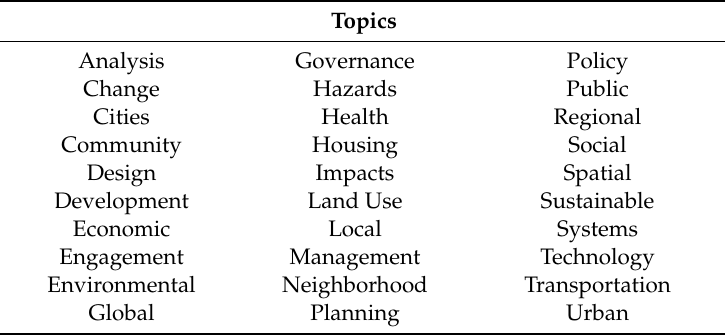
Table 1. Nodes from thematic analysis (in alphabetical order).